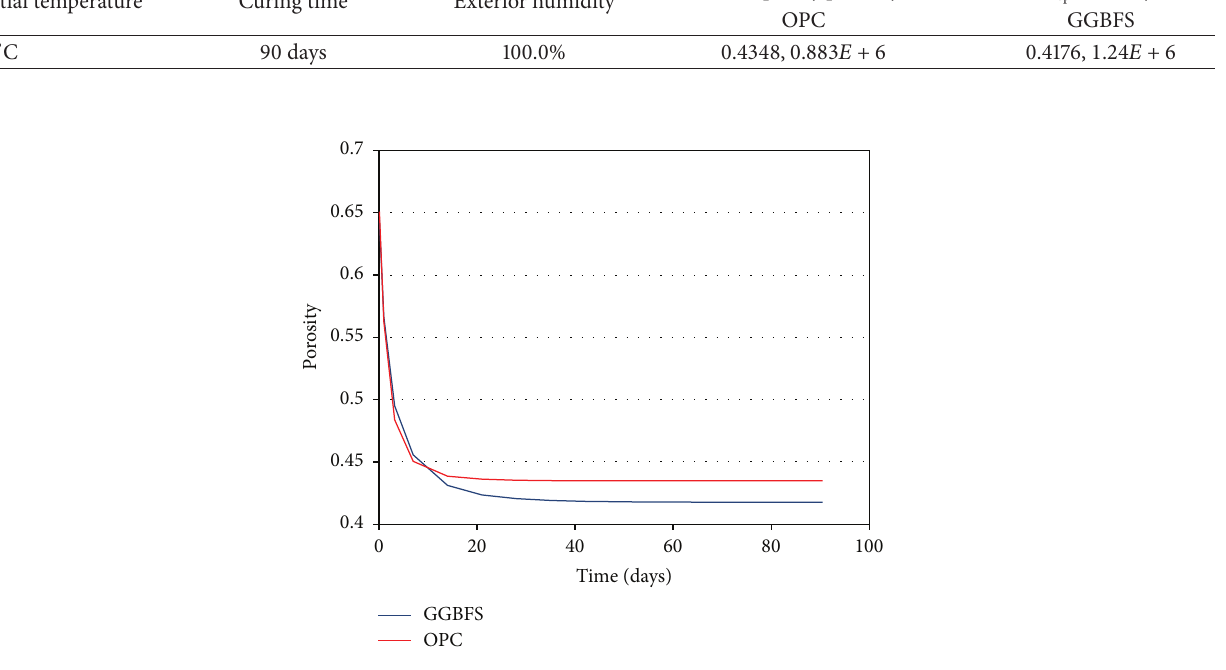
Figure 12: Changes in calculated porosity of GGBFS and OPC concrete.